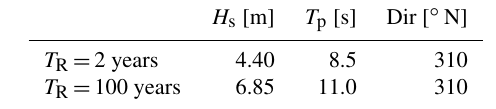
Table 2. Wave conditions extracted at the harbour entrance